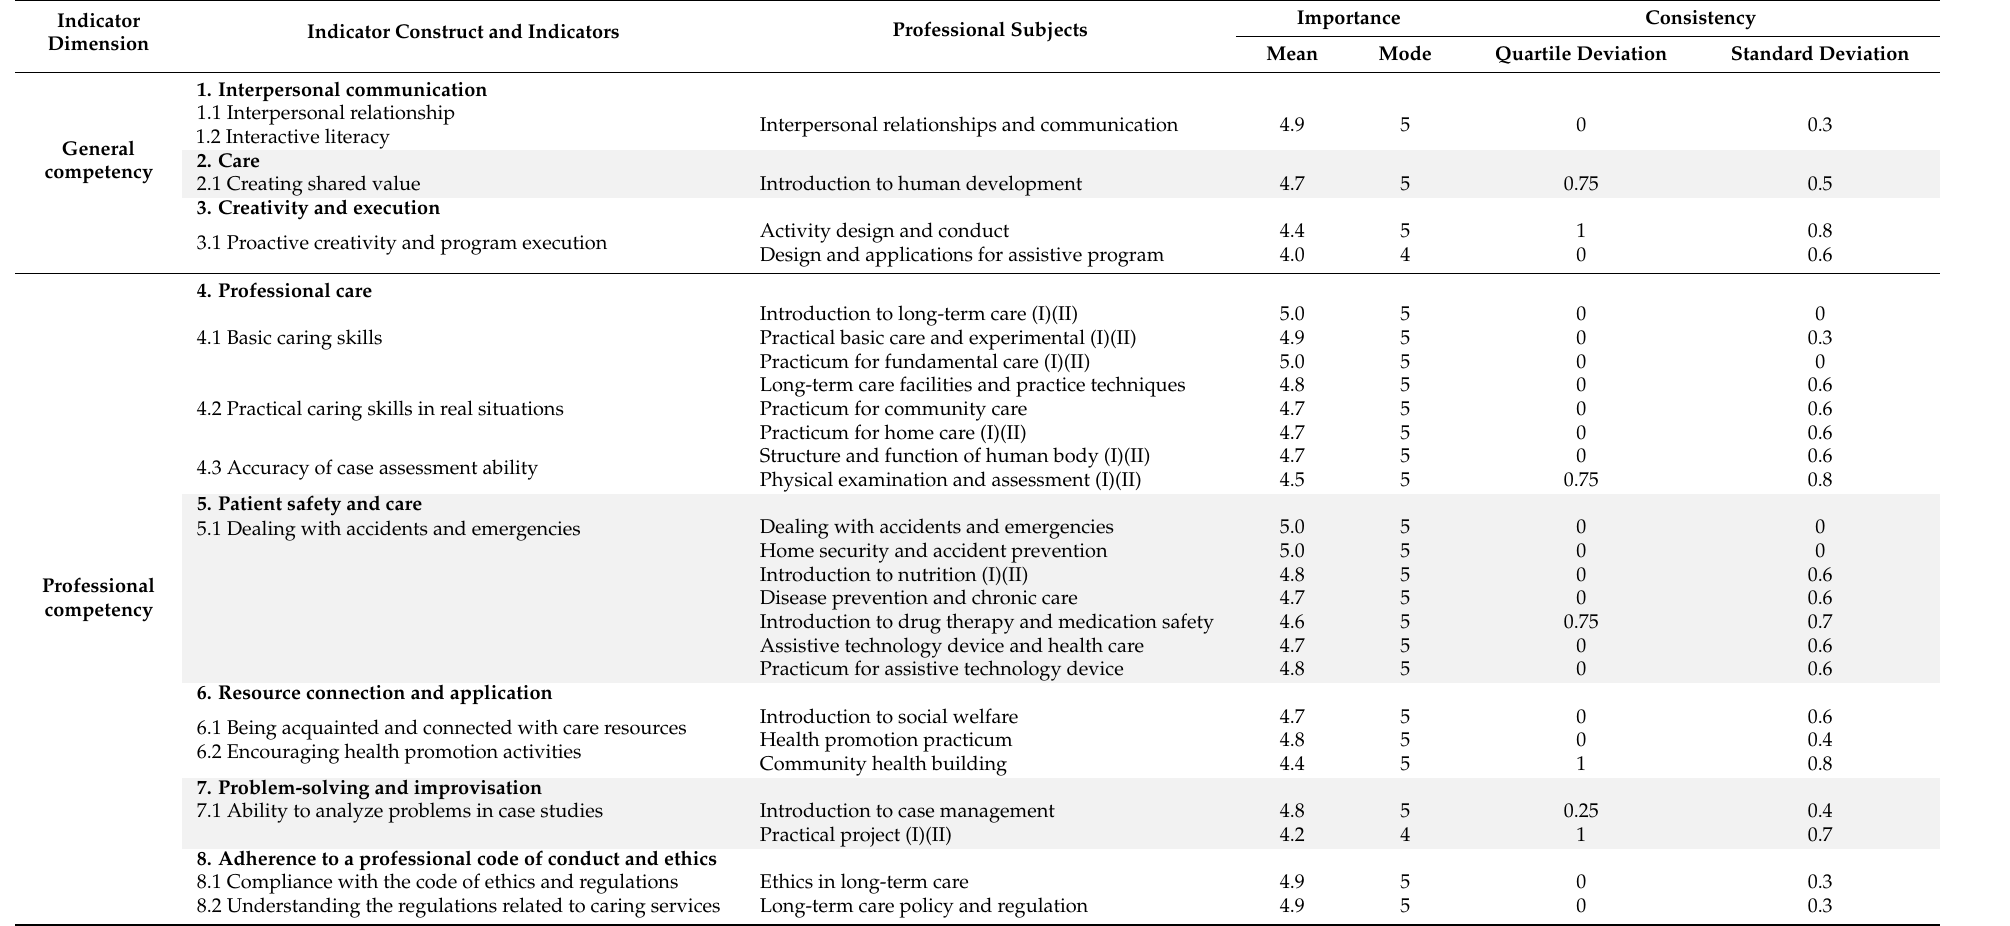
Table 6. Overall importance and consistency of the professional curriculum for care service education in vocational high schools ( n = 10). Indicator